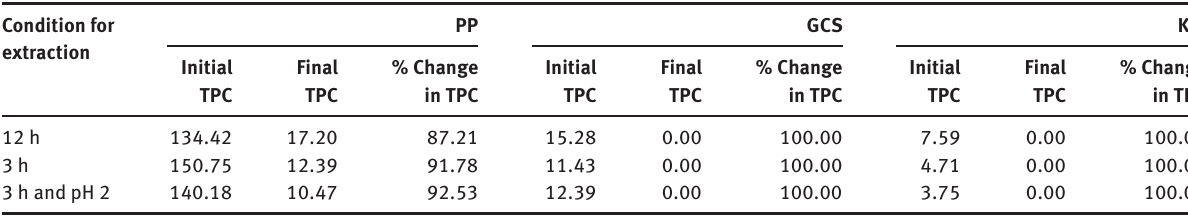
Table 2: Change in TPC before and after adsorption of Cr(VI) from 50 mg/l solution. Condition